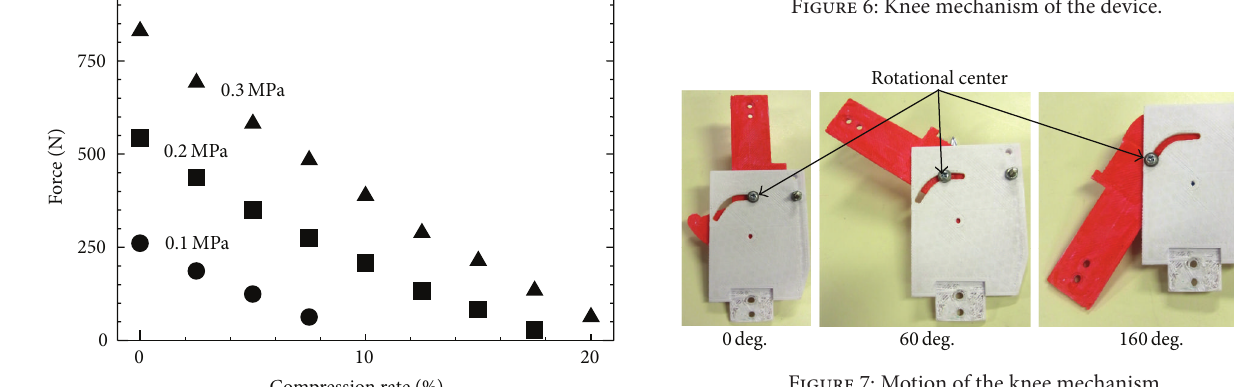
Figure 7: Motion of the knee